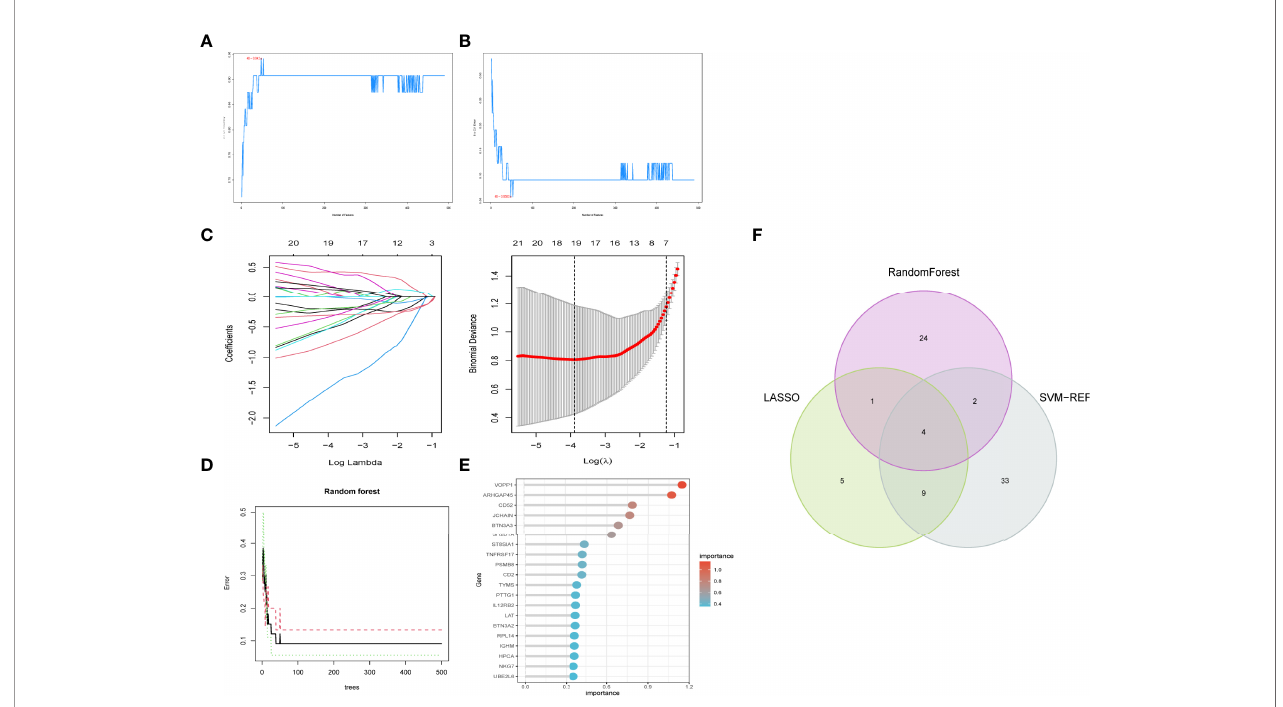
FIGURE 4 | Feature gene selection. (A,B) Biomarker signature gene expression validation by support vector machine recursive feature elimination (SVM – RFE) algorithm selection. (C) Adjustment of feature selection in the minimum absolute shrinkage and selection operator model (lasso). (D) randomForest error rate versus the number of classi fi cation trees. (E) The top 20 relatively important genes. (F) Three algorithmic Venn diagram screening